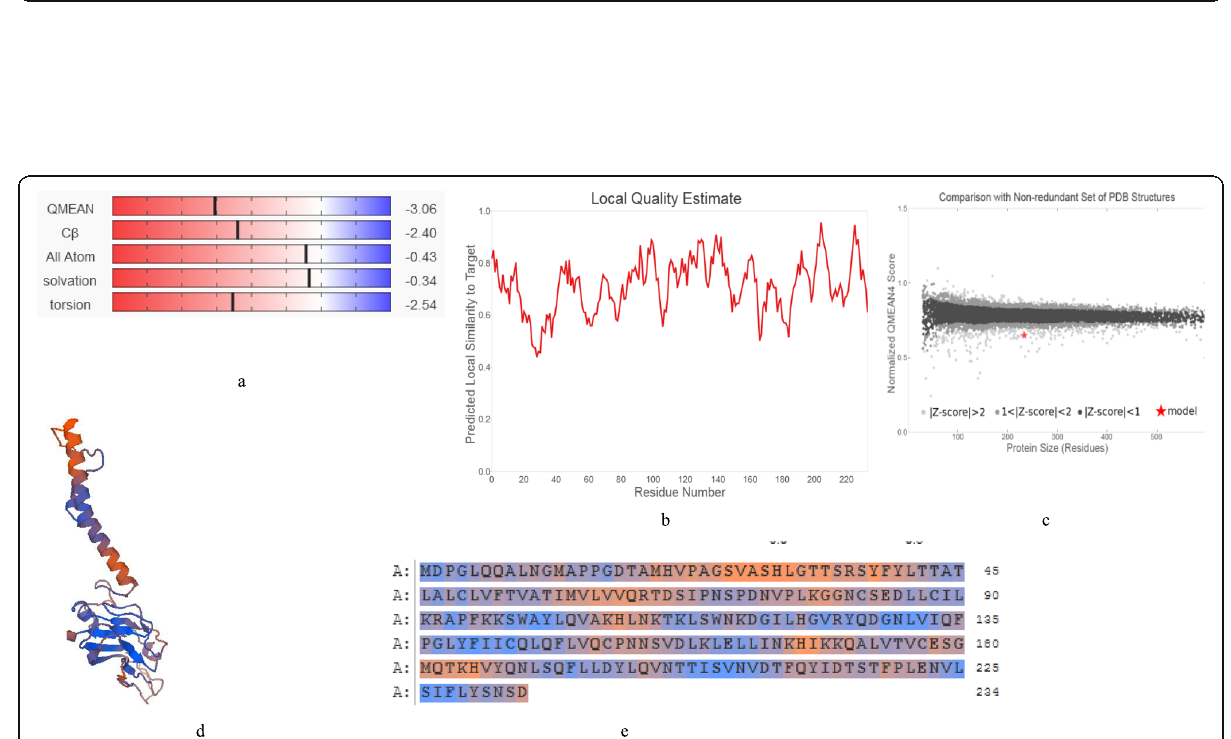
Fig. 7 Ramanchandran plot showing the residues in most favoured regions [A,B,L] = 188, residues in additional allowed regions [a,b,l,p] = 18, residues in generously allowed regions [~a,~b,~l,~p] = Nil, residues in disallowed regions = 3, number of non-glycine and non-proline residues = 209, number of end-residues (excl. Gly and Pro) = 2, number of glycine residues (shown as triangles) = 12, and number of proline residues = 11